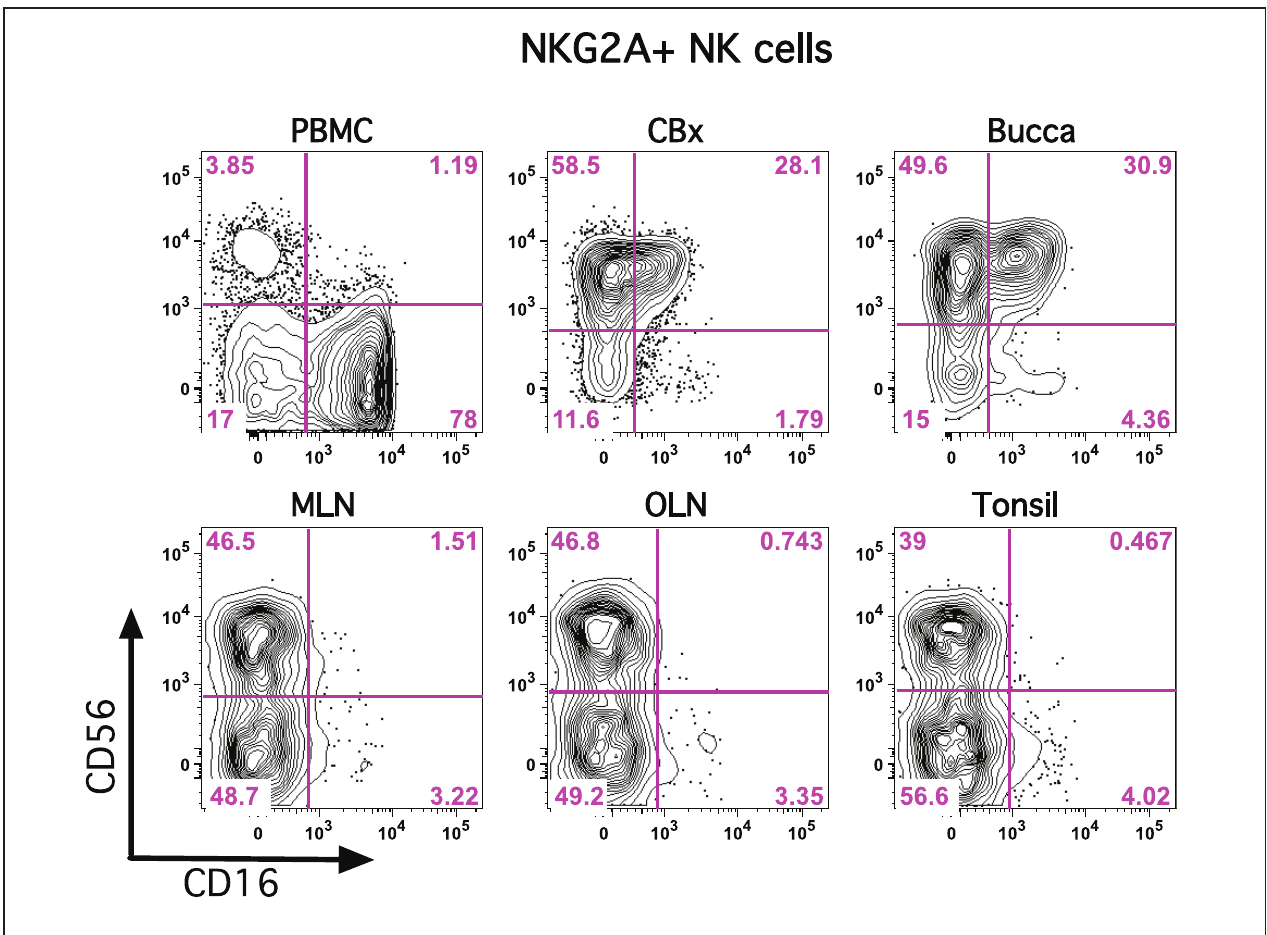
in multiple tissues. PBMC, peripheral blood mononuclear cells; CBx, colorectal biopsy; MLN, mesenteric lymph node; OLN, oral lymph node.